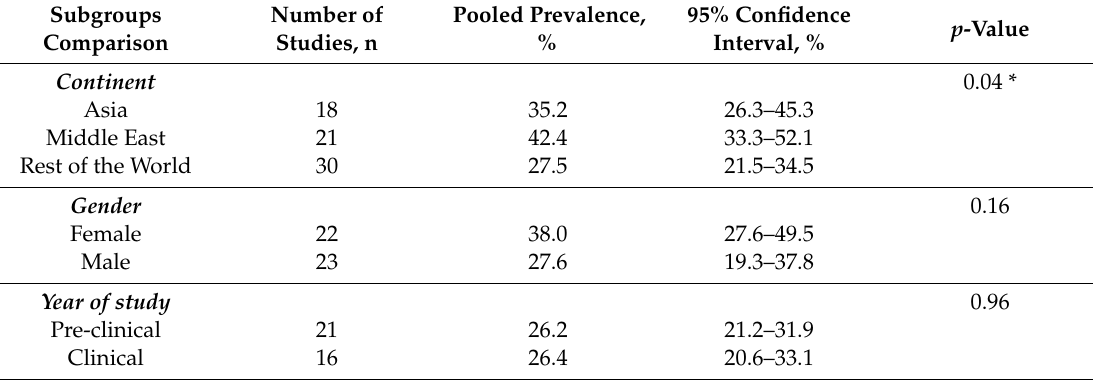
Table 2. Subgroup analyses of prevalence of anxiety in medical